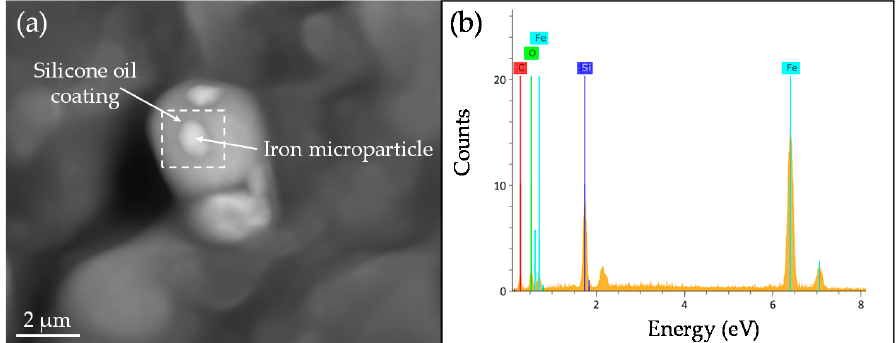
Figure 11. SEM image of NS04 and NS24 samples.